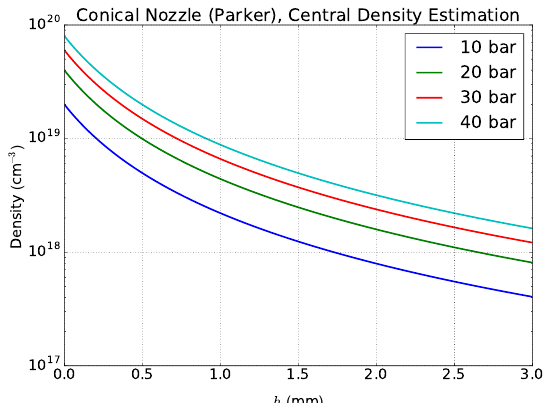
Figure 3. Estimation of the on-axis density ρ for different backing pressures. This model is based on the ideal gas law, i.e., independent of the gas